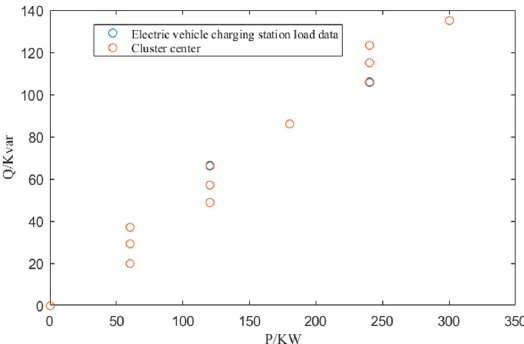
Figure 11. K ‐ means clustering results for electric vehicle charging stations without new random loads.